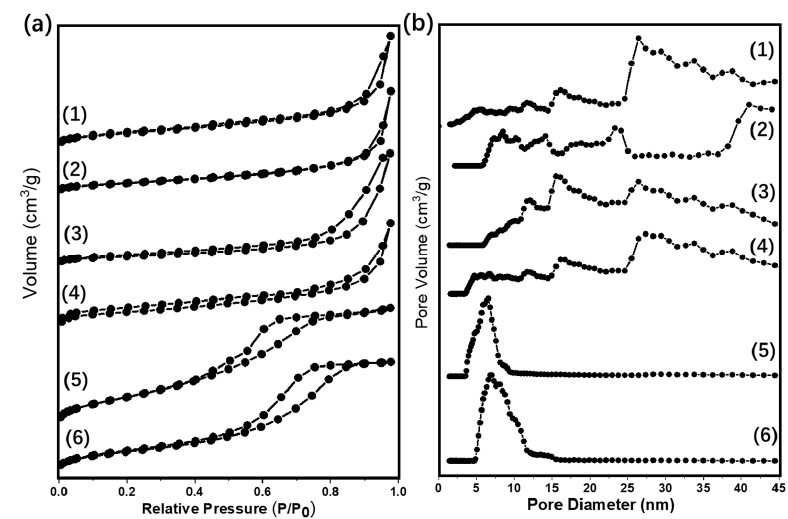
Figure 1. ( a ) N 2 adsorption/desorption isotherms and ( b ) pore size distributions of different supported gold catalysts: (1) Au 25 /ZnAl-300; (2) Au 25 /ZnO-300; (3) Au 25 /MgAl-300; (4) Au 25 /MgO-300; (5) Au 25 /Al 2 O 3 -300; (6) Au 25 /SiO 2 -300. Table 1 displayed the values of specific area, the pore volume, and the pore diameter. Over the different supported gold catalysts, the S BET decreased as the following order: Au 25 /SiO 2 -300 >